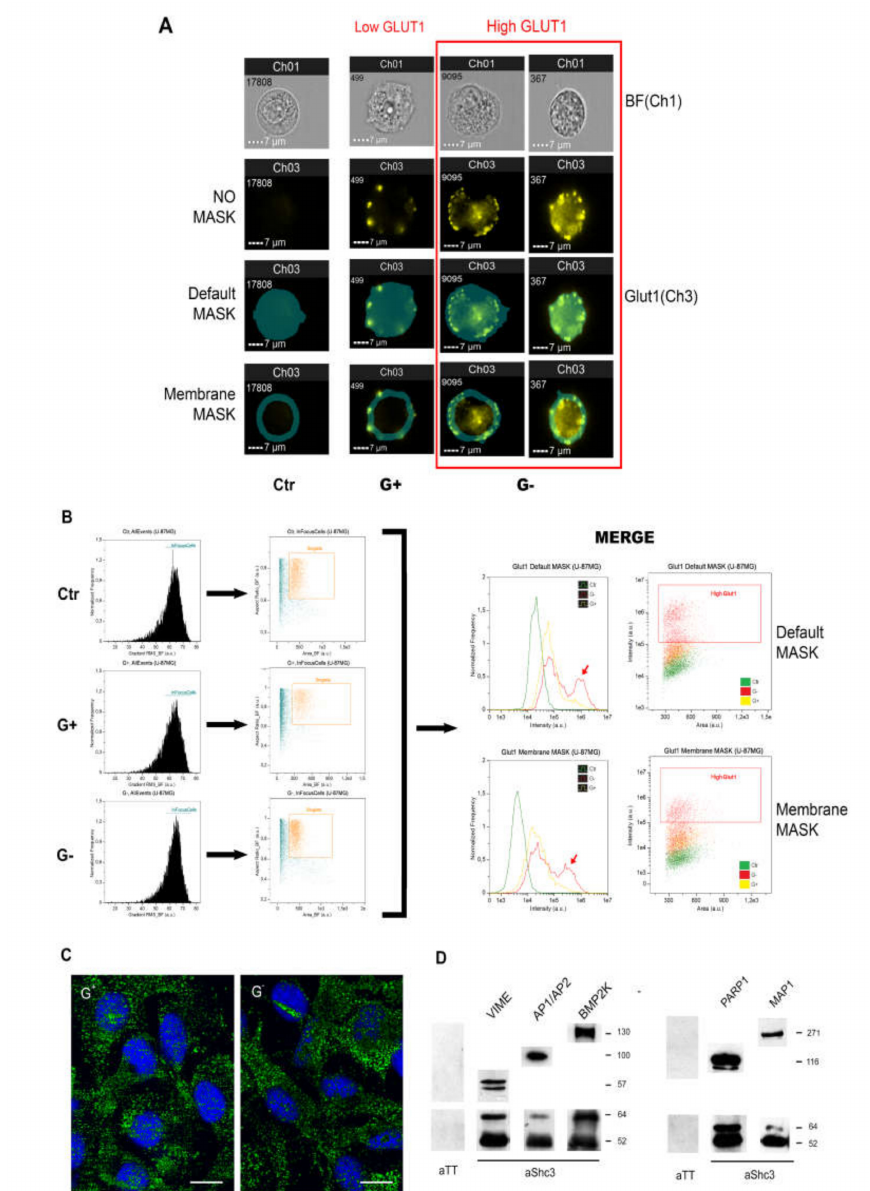
Figure 3. Glucose deprived cells have increased level of GLUT1 on the membrane and increased levels of SHC3 associated to cytoplasmic vesicles. ( A ) Living U87 MG cells were analyzed